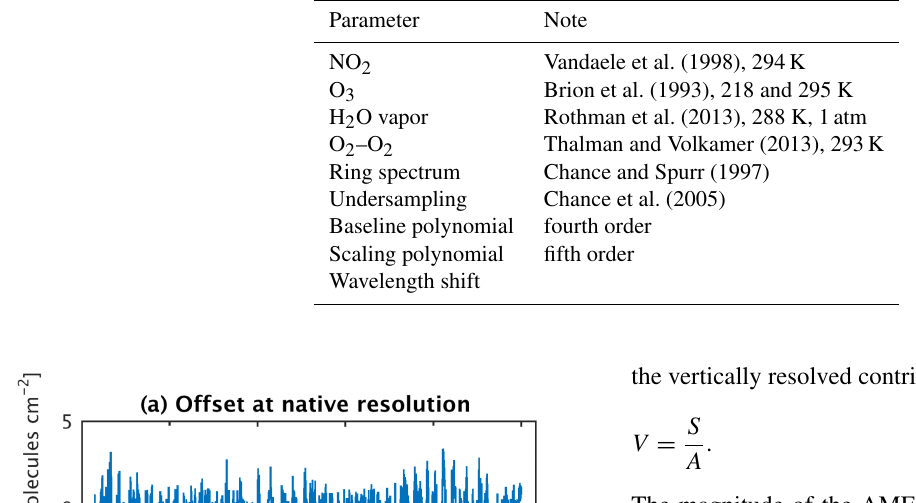
Table 6. Reference cross sections and parameters fit in NO 2 retrieval.